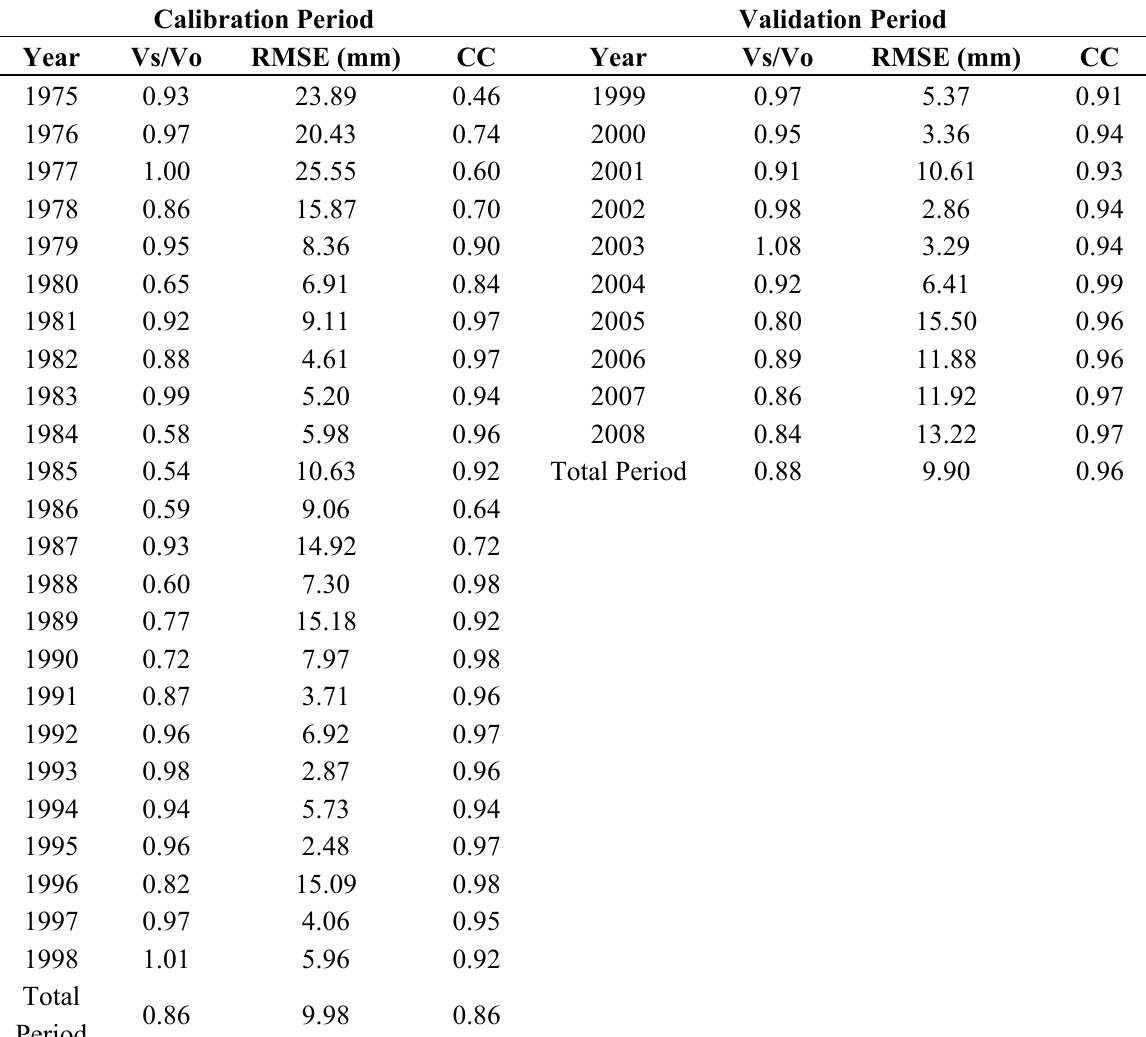
Table 2. Values of three criteria for each year during calibration and validation